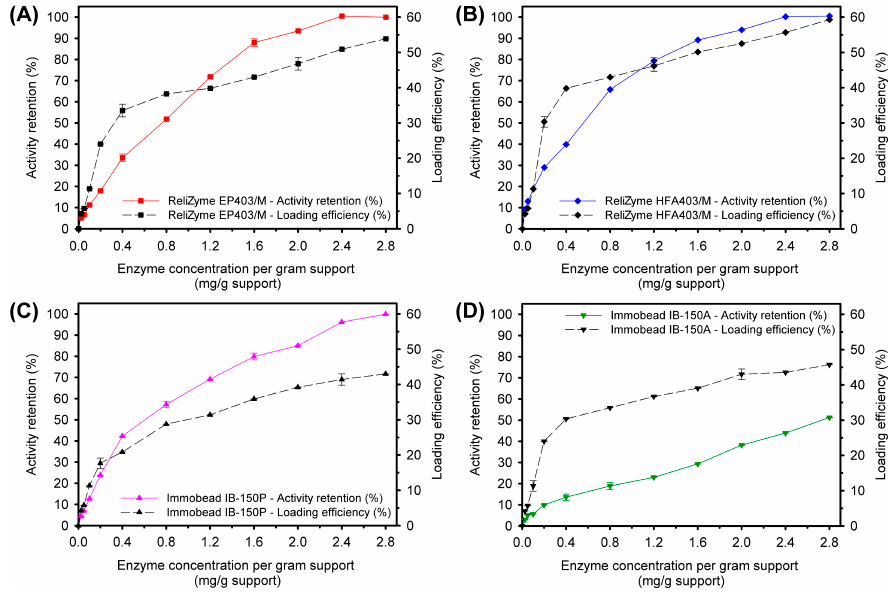
Figure 3. Activity retention and loading efficiency of the immobilized TASKA enzyme on ( A ) ReliZyme EP403/M; ( B ) ReliZyme HFA403/M; ( C ) Immobead IB-150P; and ( D ) Immobead IB-150A at different enzyme concentrations. The values shown represent the mean ± standard error of triplicate analyses.